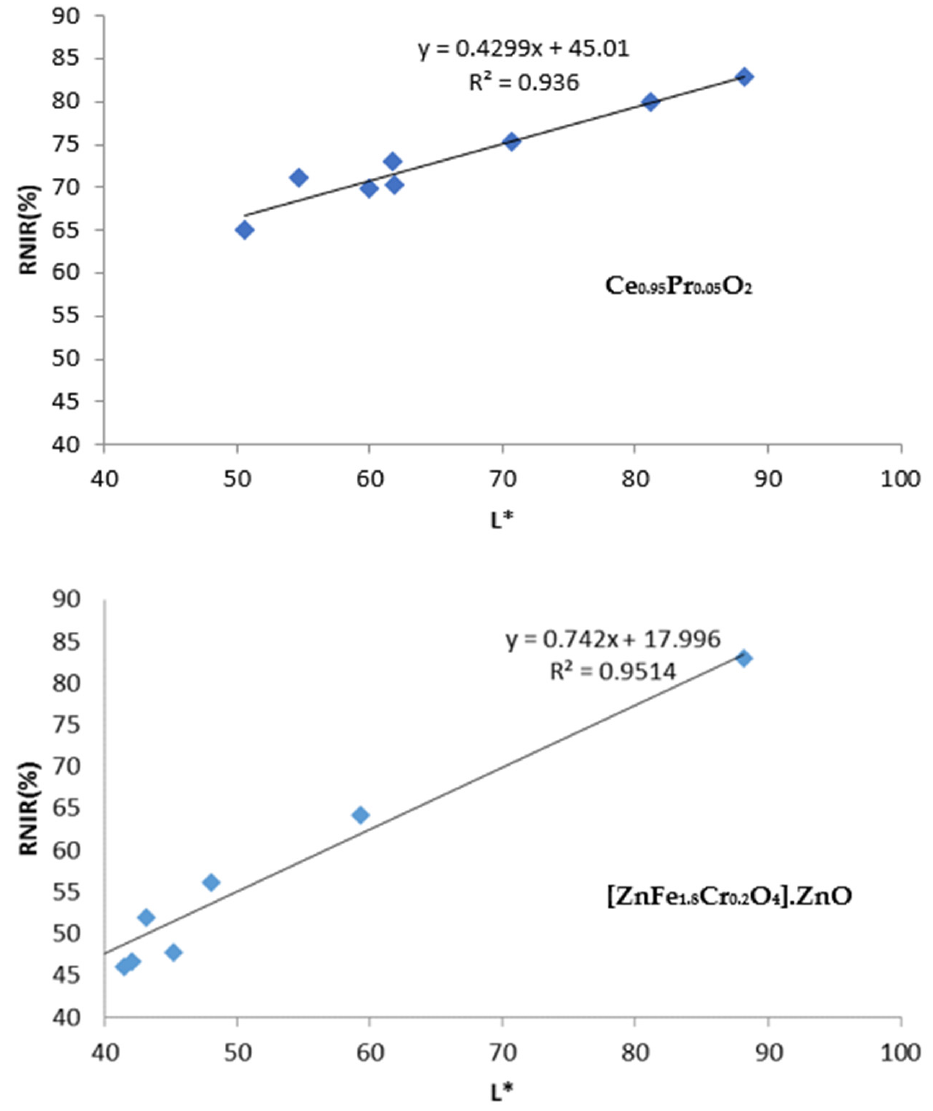
Figure 8. R NIR versus lightness L* of red-brown pigments with gradual addition of the binder CaCO 3 . (c) Regarding yellow pigments, the chroma C* is higher for the Ni,Sb-rutile pigment (C* = 54.3 vs. 45.3 for Mo-cerate pigment), and the lightness L* is similar for both yellow pigments and included in the proposed yellow range (L* = 80–90). The Mo- cerate yellow powder shows higher R NIR (81% versus 55% for Ni,Sb-rutile). The evolution of colorimetry and reflectance data with the gradual addition of CaCO 3 binder to the pigments are shown in Table 4 and the representation of R NIR versus lightness L* follows a linear relationship in Figure 9. The R NIR 85 (reflectance associated to a L* = 85, proposed for yellow hues) is 80% for the Mo-cerate pigment and 63% for classical Ni,Sb-TiO 2 decorated rutile pigment. Therefore Mo-cerate shows better performance as a cool